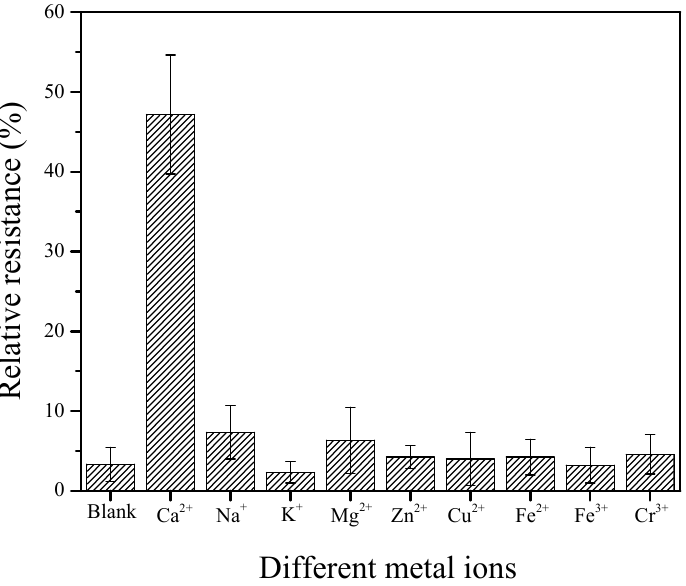
Figure 8. Relative resistances of the GCE/SWNT/DNAzymes before and after incubation in 10 mM solutions of different metal ions including, Na + , K + , Mg 2+ , Zn 2+ , Cu 2+ , Fe 2+ , Fe 3+, , and Cr 3+ .